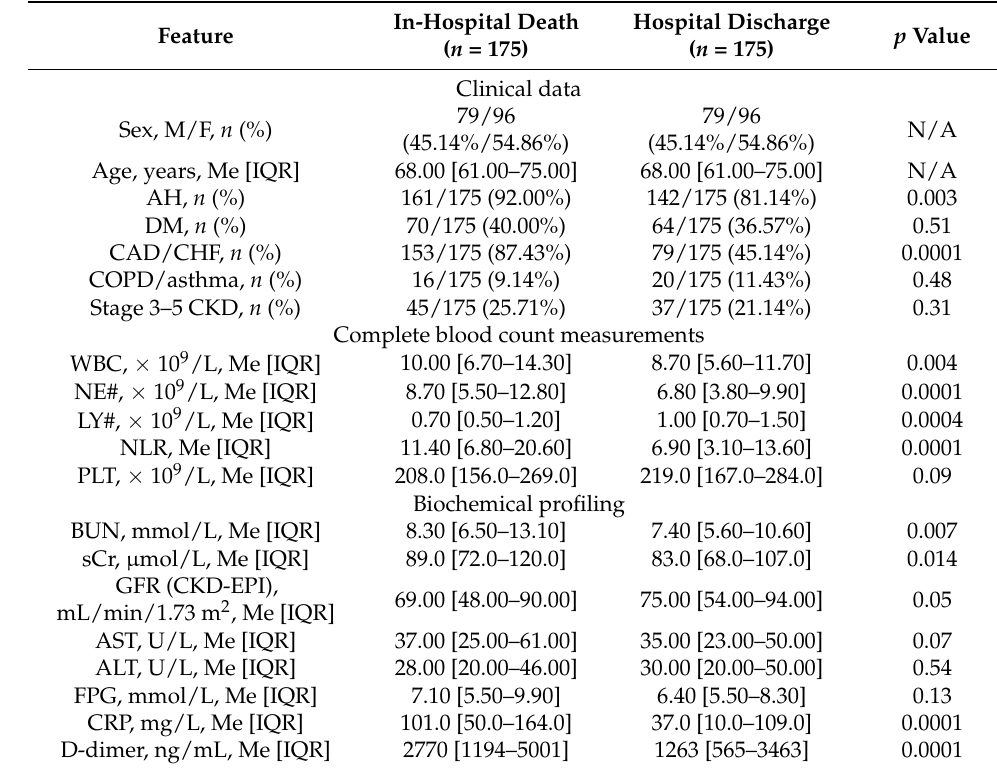
Table 2. Descriptive statistics and univariate risk factor analysis in patients with adverse (in-hospital death) and favorable (hospital discharge)